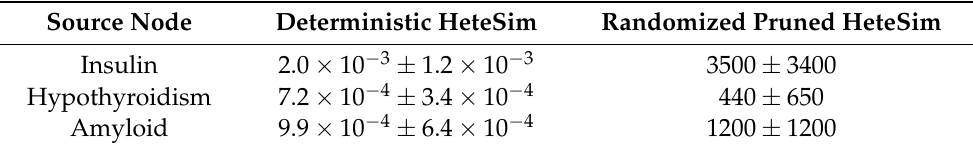
Table 4. Mean and standard deviation of runtimes for both the deterministic HeteSim and randomized pruned HeteSim algorithms on the top 20 individual length 2 metapaths.